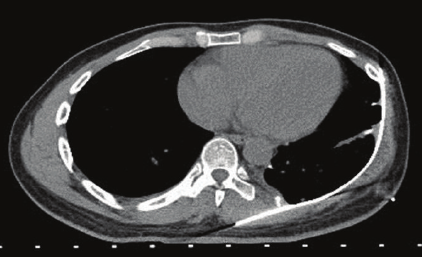
Figure 8: Follow-up axial CT chest without contrast demonstrating removal of pleural soft tissue mass, skeletal lesions, and titanium mesh chest wall